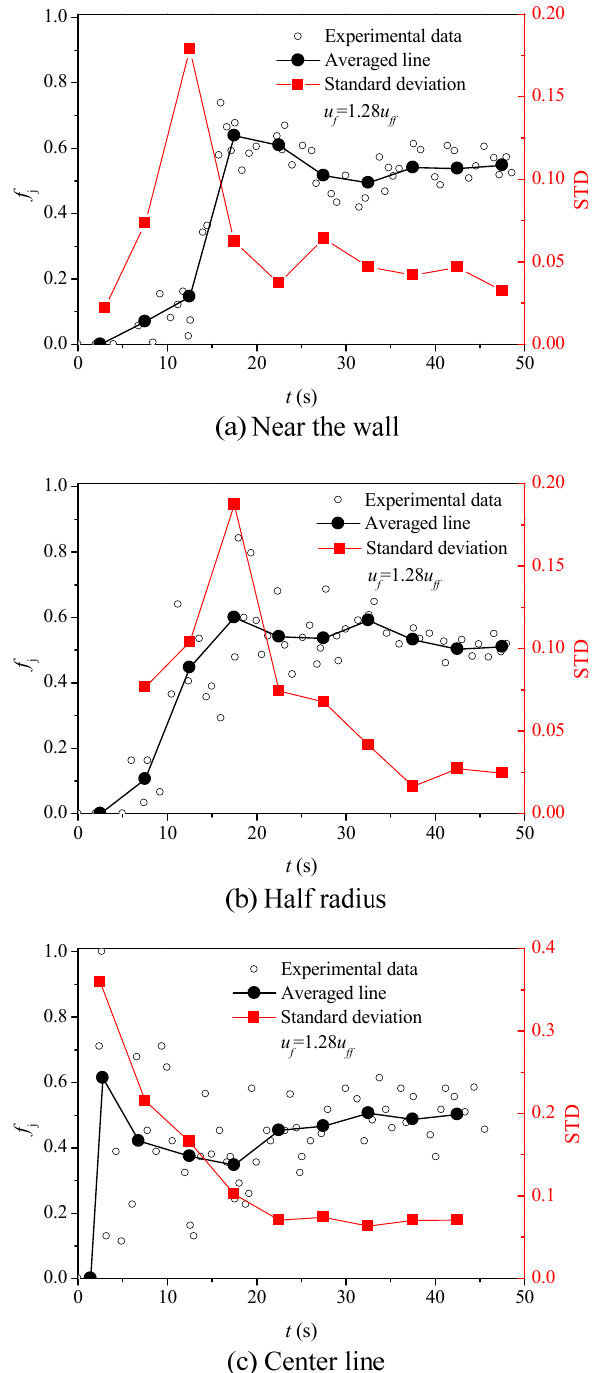
Figure 6. Variations of the micro mixing ratio and its standard deviation with time at different lateral positions when the bed height is 0.75 H 0 . ( a ) Near the wall. ( b ) Half radius. ( c ) Center.